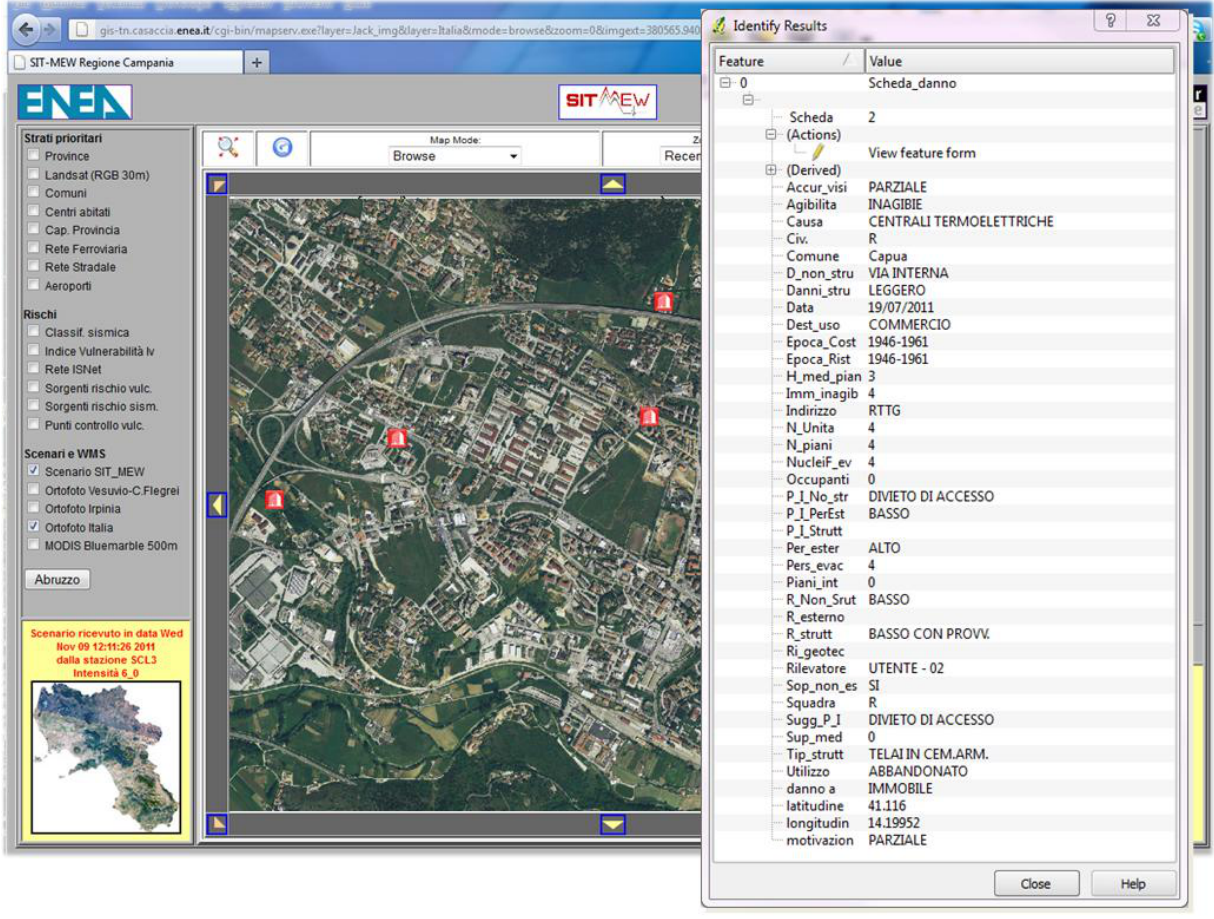
Figure 7. Post-event phase: visualization in the WebGIS of building information collected by means of handheld